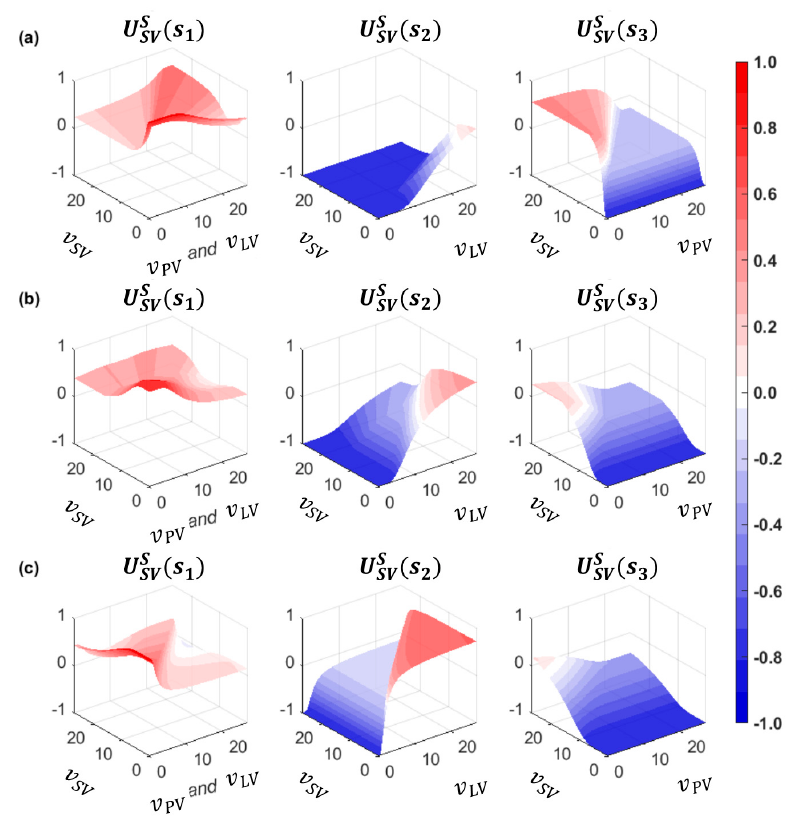
Figure 4. Safety payo ff s of the driver of SV for the s 1 , s 2 , and s 3 action: ( a ) close to the preceding vehicle (PV) ( ∆ x SV , LV = 67 m, ∆ x PV , SV = 10 m); ( b ) middle position between PV and LV ( ∆ x SV , LV = 38 m, ∆ x PV , SV = 39 m); ( c ) close to the LV ( ∆ x SV , LV = 10 m, ∆ x PV , SV = 67